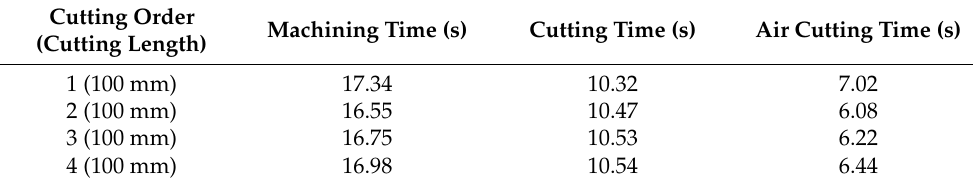
Table 8. Results of experiment 4 without empty grooves.